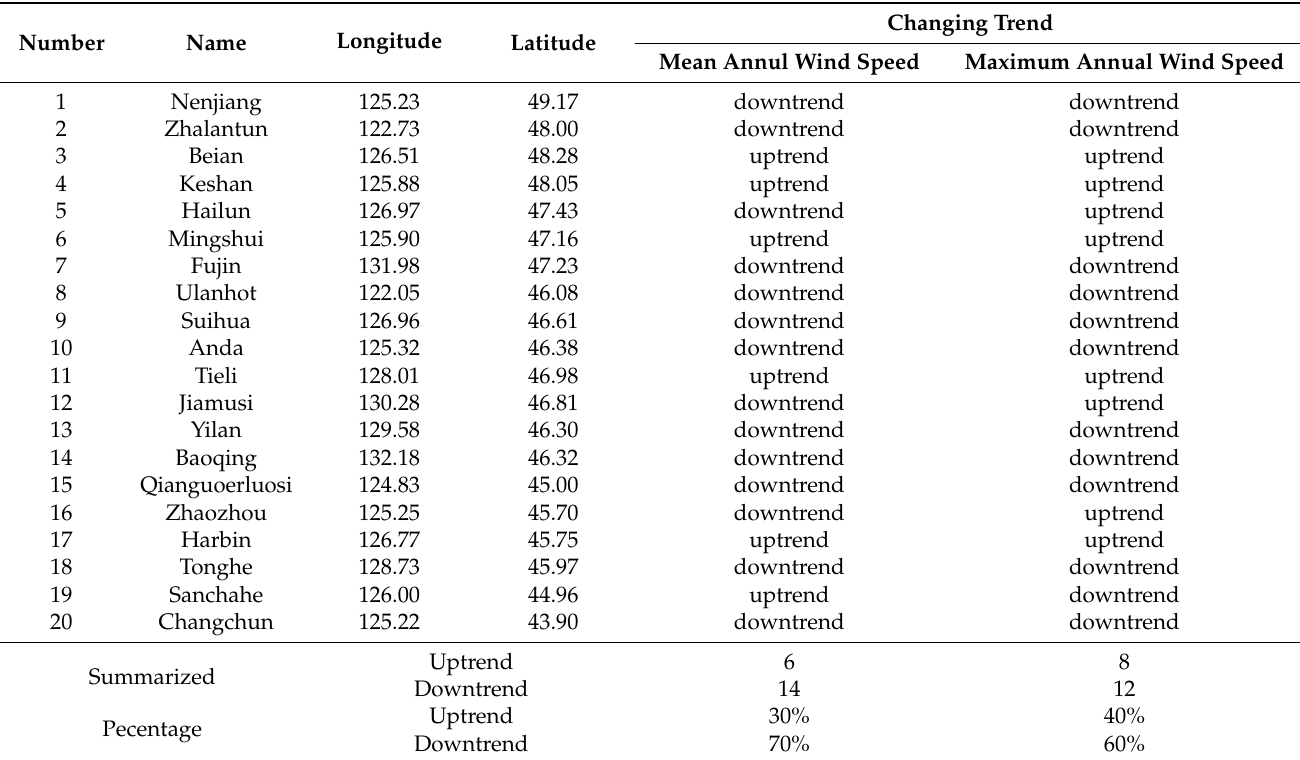
Table 3. Number of stations with different wind speed trends from 2001 to